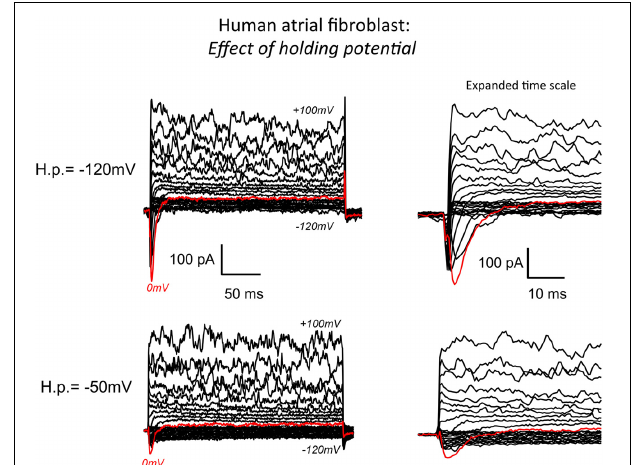
FIGURE 1 | Whole cell patch clamp records of the predominant transmembrane ionic currents recorded from an isolated human atrial myofibroblast using our standard superfusion solution at 22–23 ◦ C. The pipette solution in this experiment was “K + -rich.” (See Methods for details of solutions and voltage-clamp protocols). The superimposed current records in the bottom left panel are typical of the data recorded when the voltage clamp “holding potential” ( − 50mV) was set near the presumed resting membrane potential of the myofibroblast (approximately − 40mV). As shown, membrane depolarizations in the voltage range from about + 20 to 100mV resulted in a large “noisy” outward current that is likely generated by Ca 2 + -activated K + channels. In this and most other recordings, hyperpolarization from HP − 50mV produced only very small current changes (see Chilton et al., 2007). Note, however, that depolarizing steps did elicit (red trace) a small but distinct transient inward current. The same records at an expanded time scale are shown on the right. The data in the top panel were obtained in response to the same levels of step depolarizations applied from a holding potential of − 120mV. As expected from the fundamental biophysical properties of a voltage-dependent Na + (or Ca 2 + ) current this hyperpolarized HP “unmasked” a much more prominent transient inward current (see